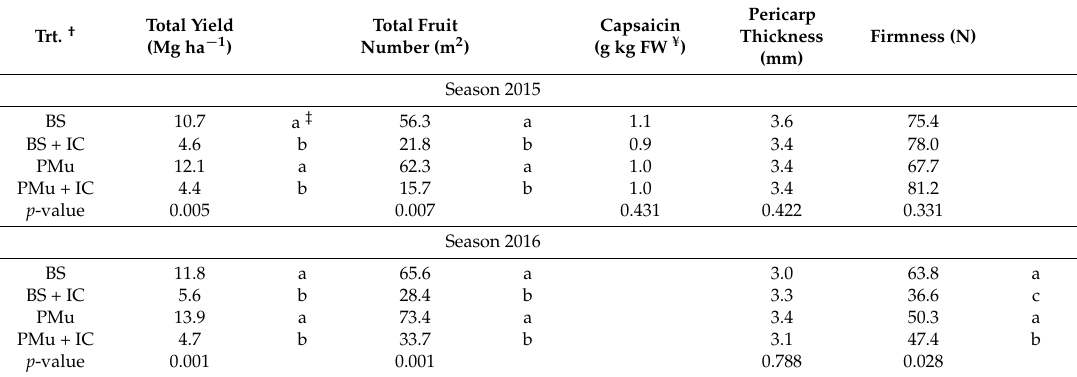
Table 1. Jalapeño pepper yields, fruit number, capsaicin concentration, pericarp thickness and fruit firmness as affected by plastic mulch and intercropping, during two growing